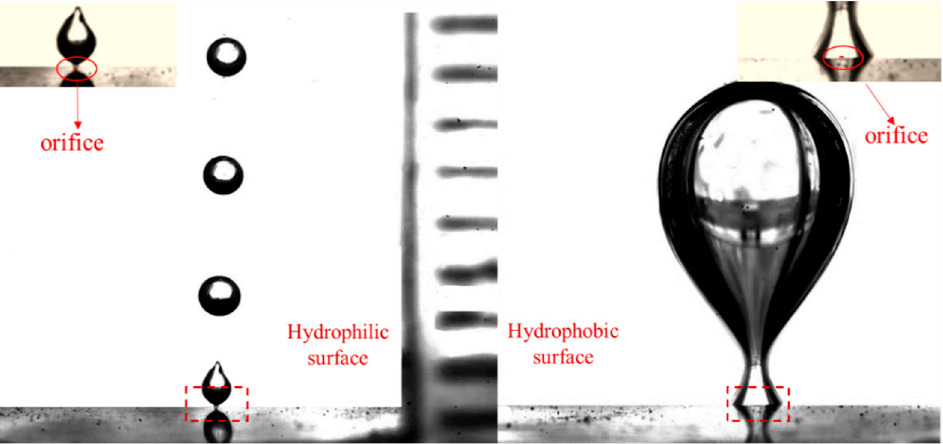
Figure 4. Comparison of contact rims of bubbles for a hydrophilic surface (contact angle: 3.58°) and a hydrophobic surface (contact angle: 116.52°).